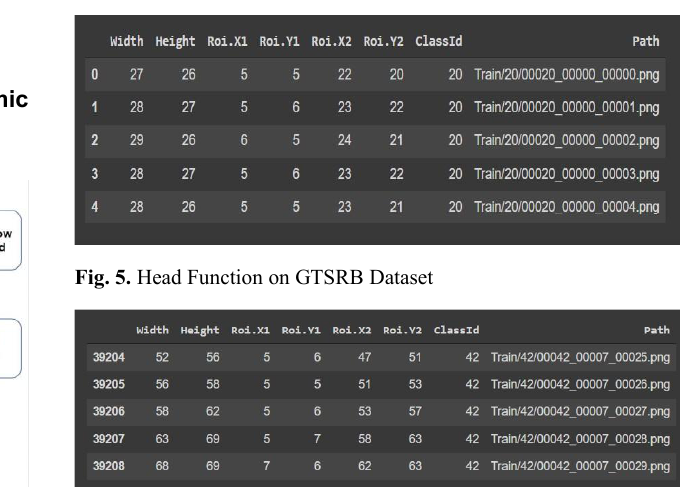
Fig. 4. Proposed System Diagram for Classification of Dynamic Images Fig. 4 represents details For Dynamic or Real-Time Recognition, Classify Video button provided on System User